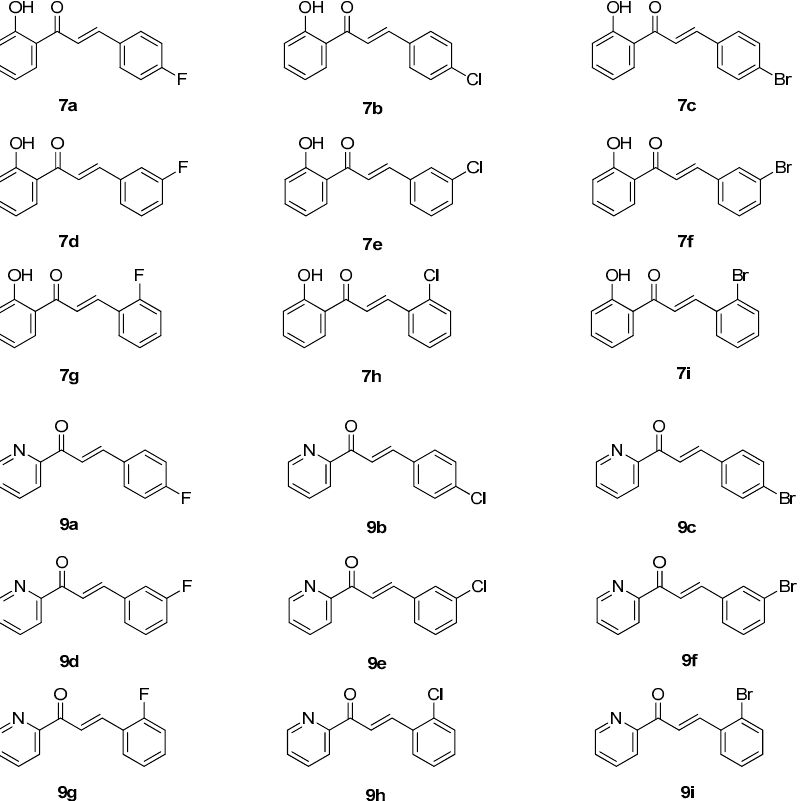
Figure 5. Chemical structures of synthetic chalcones 7a – i and azachalcones 9a – i in this study.